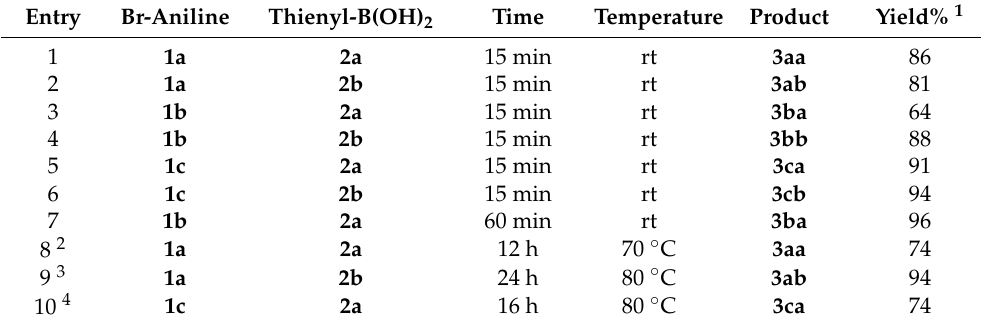
Table 1. Output of micellar Suzuki cross-coupling between mono-bromoanilines and thienyl boronic acids. Entry Br-Aniline Thienyl-B(OH) 2